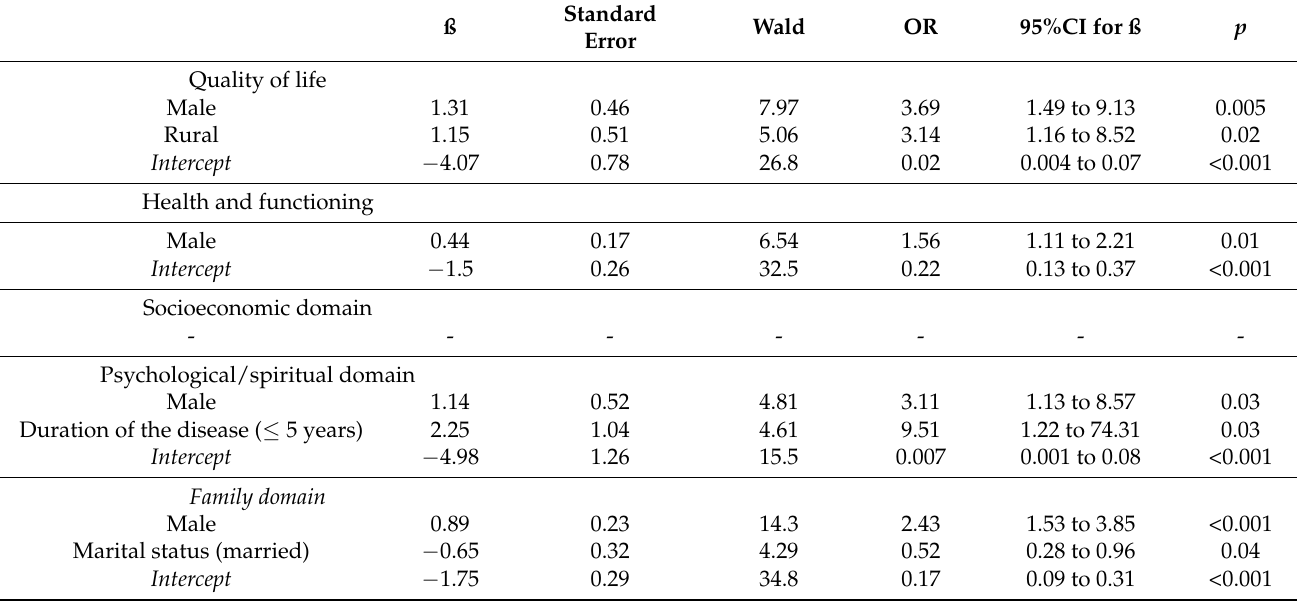
Table 6. Significant predictors of worse quality of life in patients with type 2